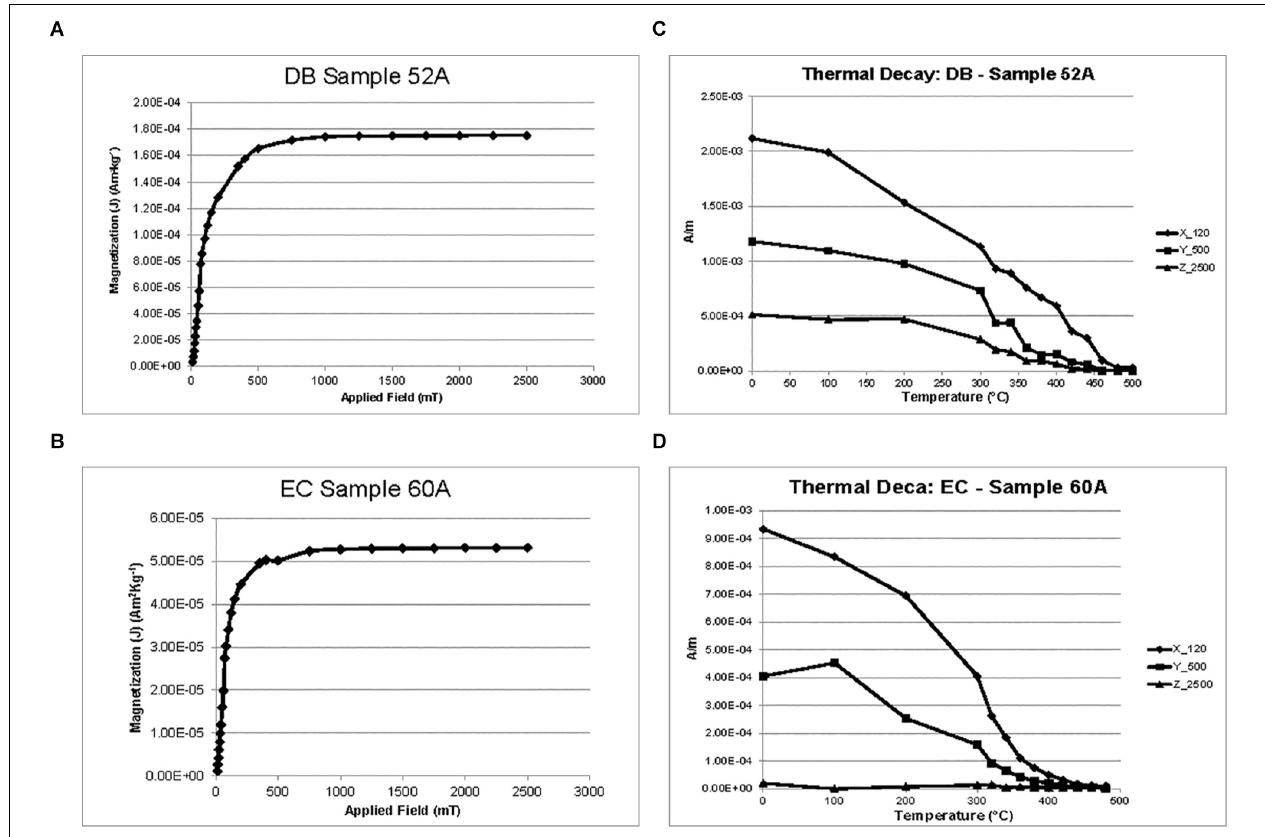
FIGURE 8 | Representative IRM acquisition (A,B) and triaxial decay (C,D) curves for the DB (A,C) and EC (B,D) . The low and intermediate thermal curves decay by 500 ◦ C suggesting magnetite. A slight dip at 320 ◦ C suggests the presence of pyrrhotite.